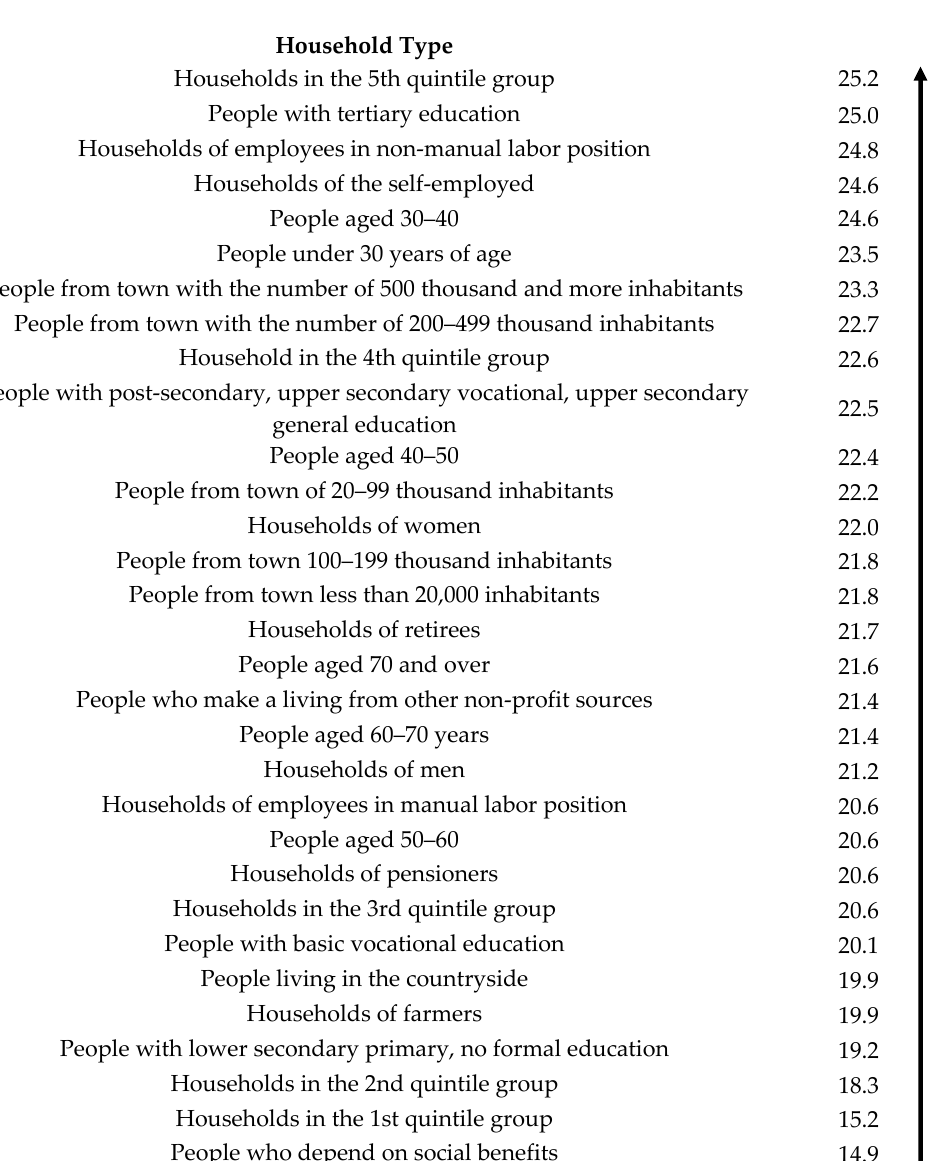
Scheme 1. Hierarchy of types of one-person households determined by the aggregate indicator. Source: own study and calculations based on CSO data. Table 4. The impact of economic and socio-demographic variables of people running one-person households on the aggregate indicator.